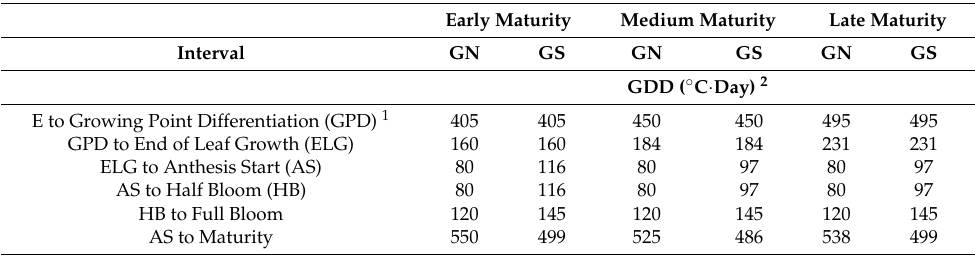
Table 4. Sorghum growing degree-days (GDD) for no water stress (GN) and maximum non-terminal water stress (GS) phenological parameters for early, medium, and late maturity